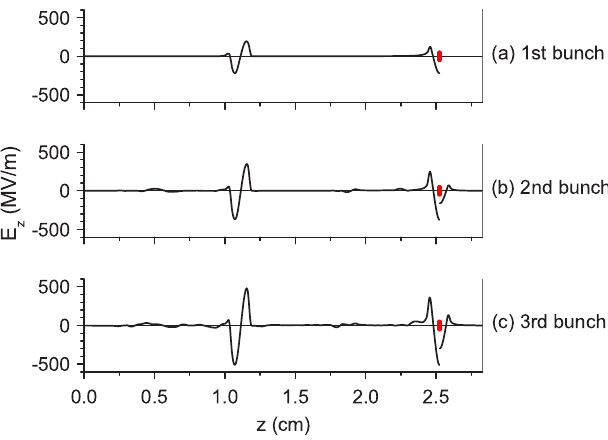
FIG. 13. (Color) Acceleration gradient when each of (a) 1st bunch, (b) 2nd bunch, and (c) 3rd bunch is in the cavity. The field was measured on r ¼ 0 : 01 R because it diverges on the z